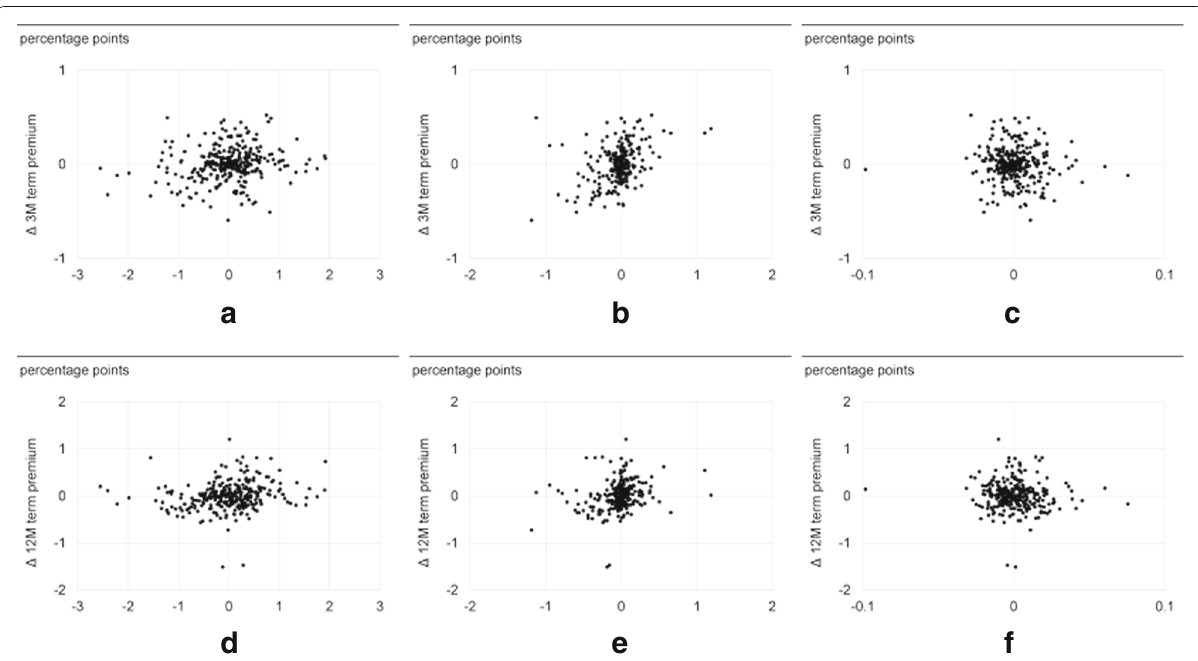
Fig. 6 Scatter plots of first differences for term premium and economic variables. The figure shows the scatter plots for the regressions reported in Table 9. a (cid:3) BCI. b (cid:3) Libor 3 M . c (cid:3) CHF real. d (cid:3) BCI. b (cid:3) Libor 3 M . c (cid:3) CHF real